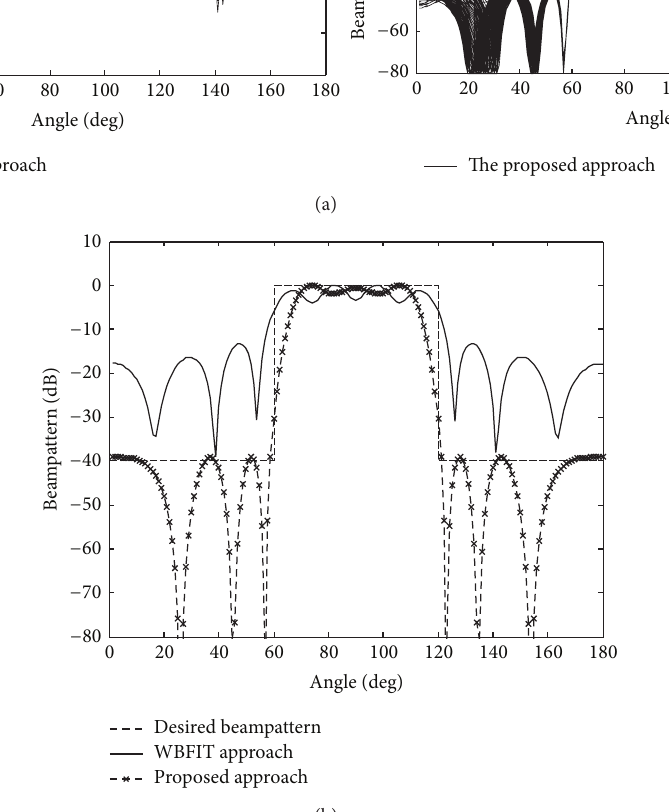
Figure 2: Comparison of the synthesized beampattern. The desired beampattern is given in (24). (a) Plot using the WBFIT approach and the proposed approach. (b) Plot at center